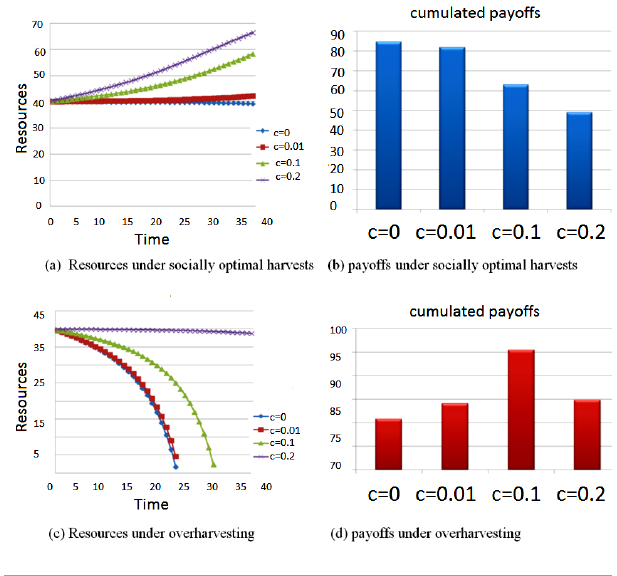
Fig. 1 . Optimal intergroup cooperation; parameter values are equal to values used in the experiment; initial harvests are equal to 2 in (a) and (b), and to 2.5 in (c) and (d), for beta = 1.